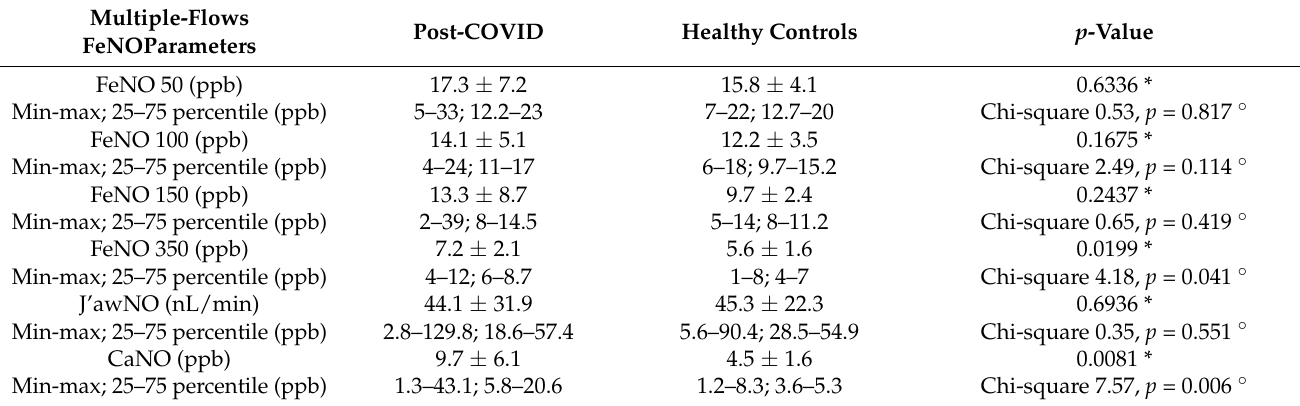
Table 2. Multiple-flow FENO parameter values between post-COVID-19 and HC. *: Mann–Whitney U test; ◦ : median test. Multiple-Flows